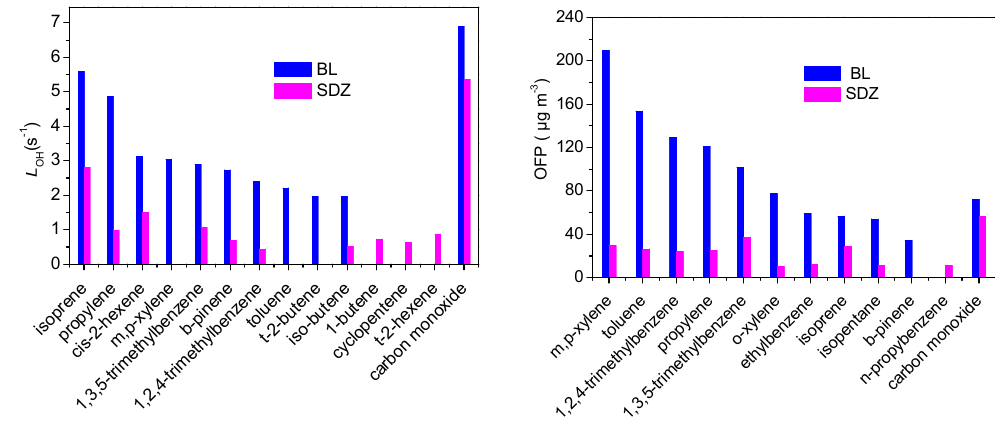
Fig. 7. The CO and top 10 NMHCs with the largest value of OH loss rate coefficient ( L OH ) (left) and ozone potential formation (OFP) (right) at BL and SDZ.